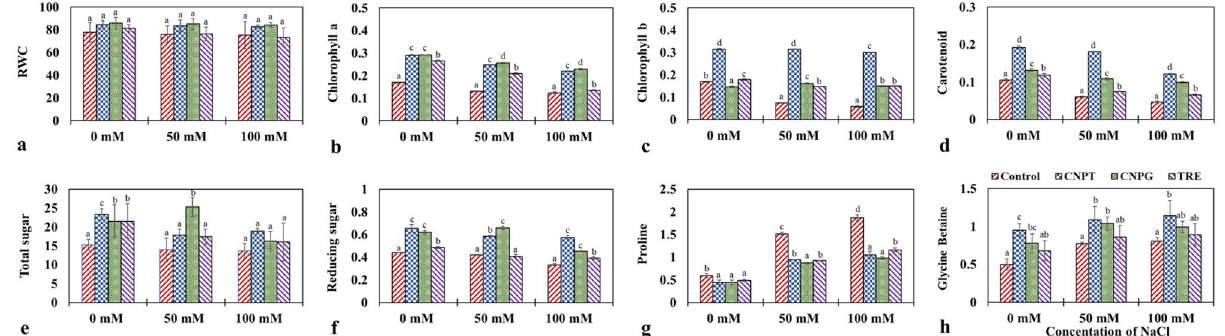
Figure 4. Changes in physiological and osmolyte status of NaCl stressed Vigna radiata seedlings following the application of CNPT, CNPG and TRE. ( a ) RWC (%); ( b ) Chlorophyll- a (mg g −1 f.w.t); ( c ) Chlorophyll- b (mg g −1 f.w.t); ( d ) Carotenoid (mg g −1 f.w.t); ( e ) Total sugar (mg g −1 f.w.t); ( f ) Reducing sugar (mg g −1 f.w.t); ( g ) Proline (mg g −1 f.w.t); ( h ) Glycine betaine (mg g −1 d.w.t). f.w.t fresh weight tissue, d.w.t dry weight